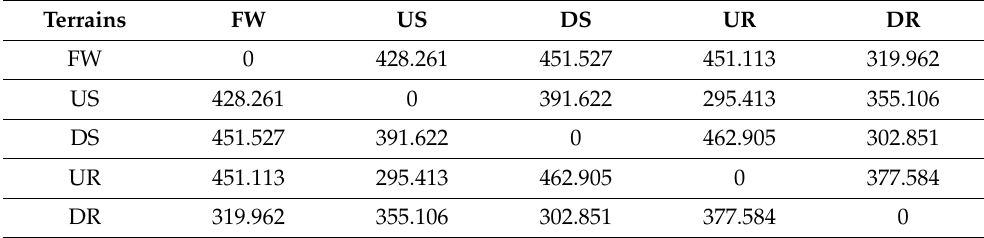
Table 2. The DTW distance for different locomotion modes.